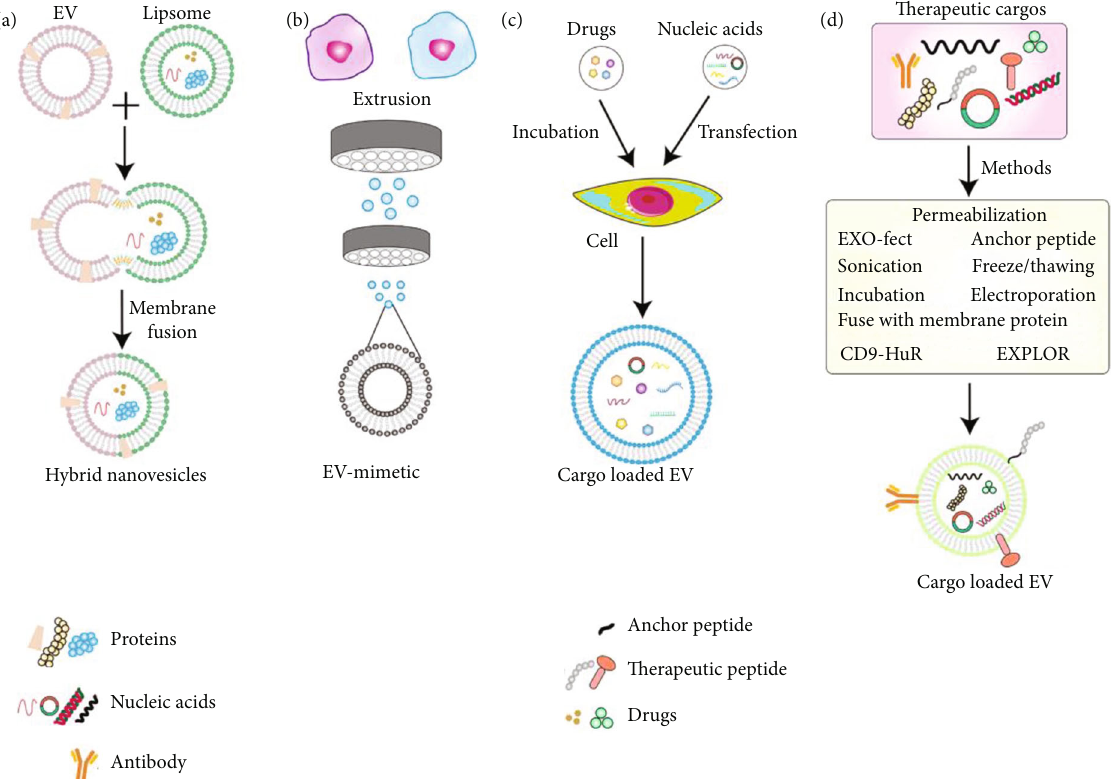
Figure 3: Approaches for loading therapeutic cargos into EVs. (a) Cargo encapsulated hybrid nanovesicles are generated via fusing EVs with therapeutic agents containing liposome. (b) EV mimetic packaging a large number of bioactive molecules is formulated by extrusion. (c) Therapeutic cargos primarily including drugs and nucleic acids are packaged into EVs through indirectly cellular transfection and incubation. (d) Therapeutic cargoes including nucleic acids, drugs, proteins, therapeutic peptides, and antibody are transferred into EVs by permeabilization, Exo-Fect, sonication, freeze/thaw and electroporation, CD9-HuR, EXPLOR, fuse therapeutic with EV membrane protein, and therapeutic peptide and antibody also can be linked to EV by anchor